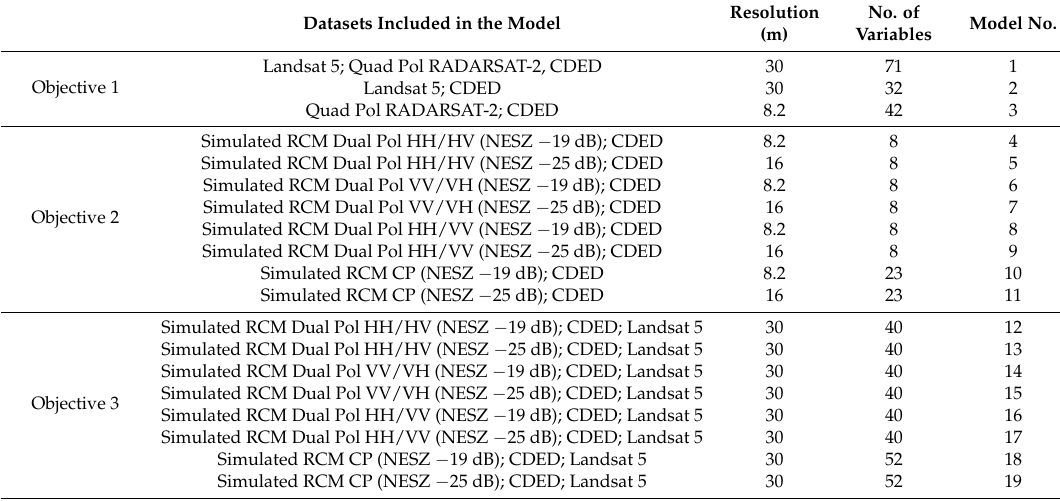
Table 7. Model configurations tested to address the first three objectives of this